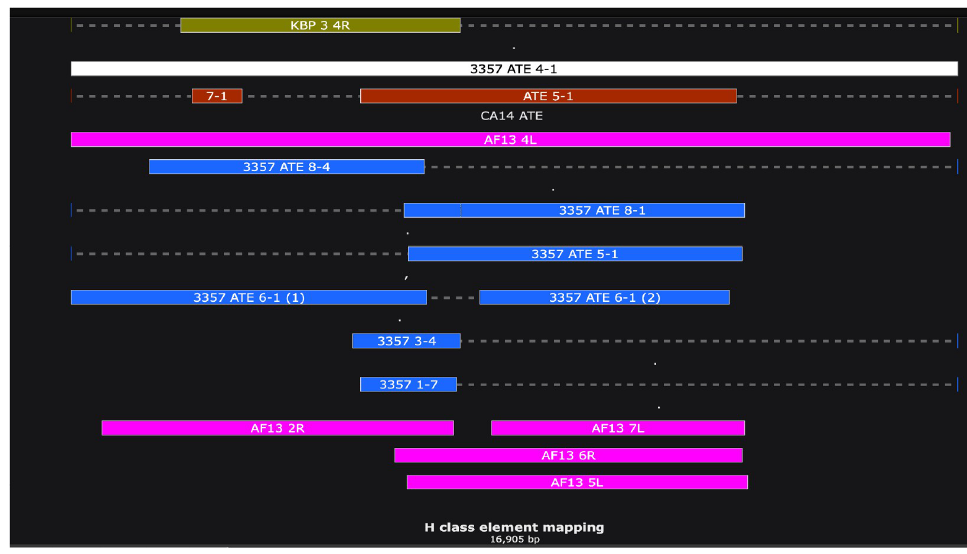
downstream TEs and homologies, both in the subtelomeric adjacent sequences of chromo- some 4L in AF13 and NRRL 3357 and at other flanking sequences of H class species (S3H Fig). The regions of homology among different H class sequences relative to the NRRL 3357 4–1 ATE. The different colors correspond to different strains: purple, AF13; green, A . oryzae strain KBP3; blue, NRRL 3357; red, CA14. The AF13 Chromosome 4L telomere is 99% identical to NRRL 3357 ATE 4–1.